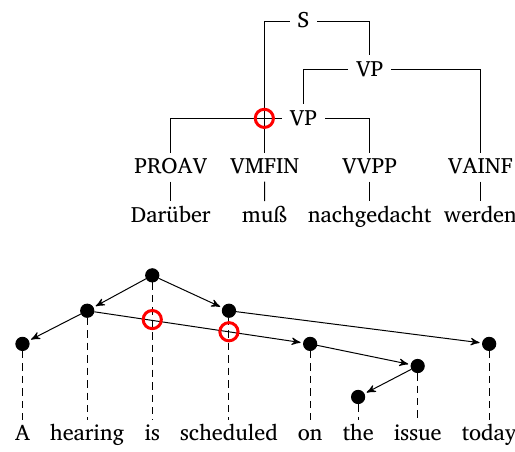
A non-projective constituency tree (taken from Maier and Søgaard